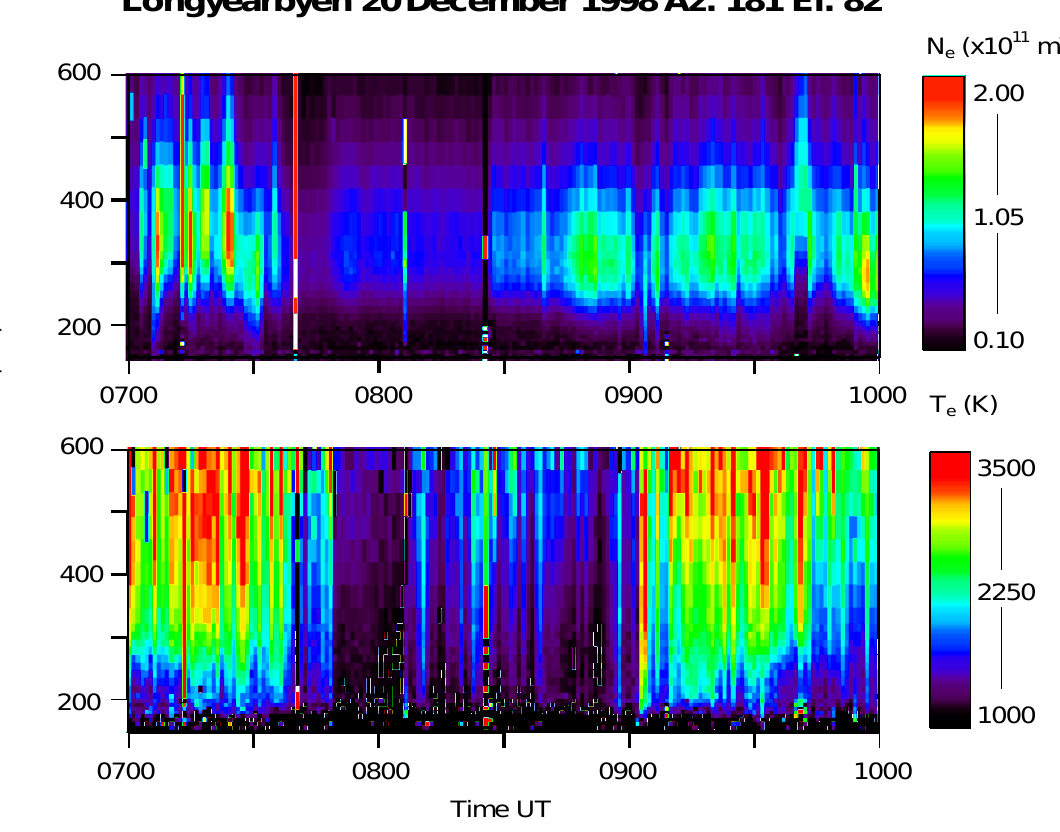
Fig. 1. Electron densities (upper panel) and electron temperatures (lower panel) measured by the ESR radar between 07:00 UT and 10:00 UT on 20 December